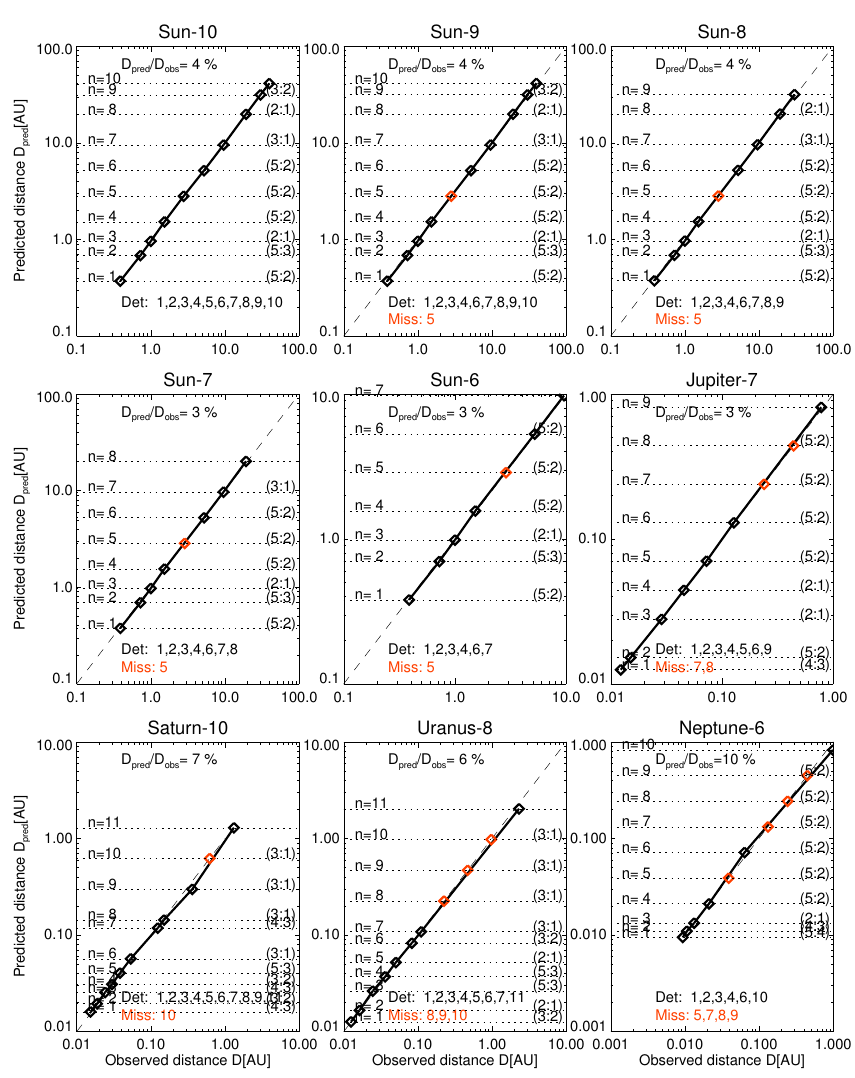
Figure 4. Solar and planetary systems, with representation similar to Figure